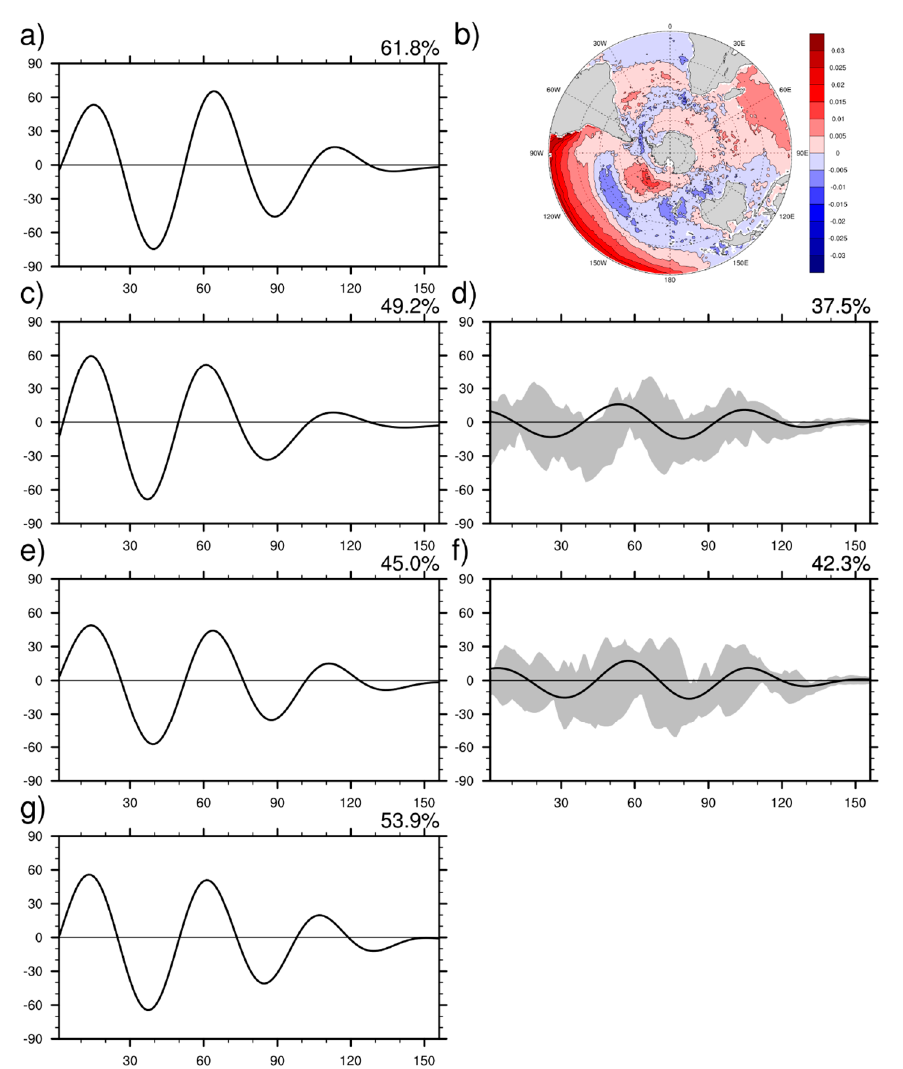
Figure 7. Time series and spatial pattern for the first EOF mode of SST from the ERA5 dataset ( a , b ) and selected models ( c – g ), with the explained percentage of variance given on the top right (5–95% percentile shaded). Models ( c – g ) are the same as Figure 6 ( b – f ).